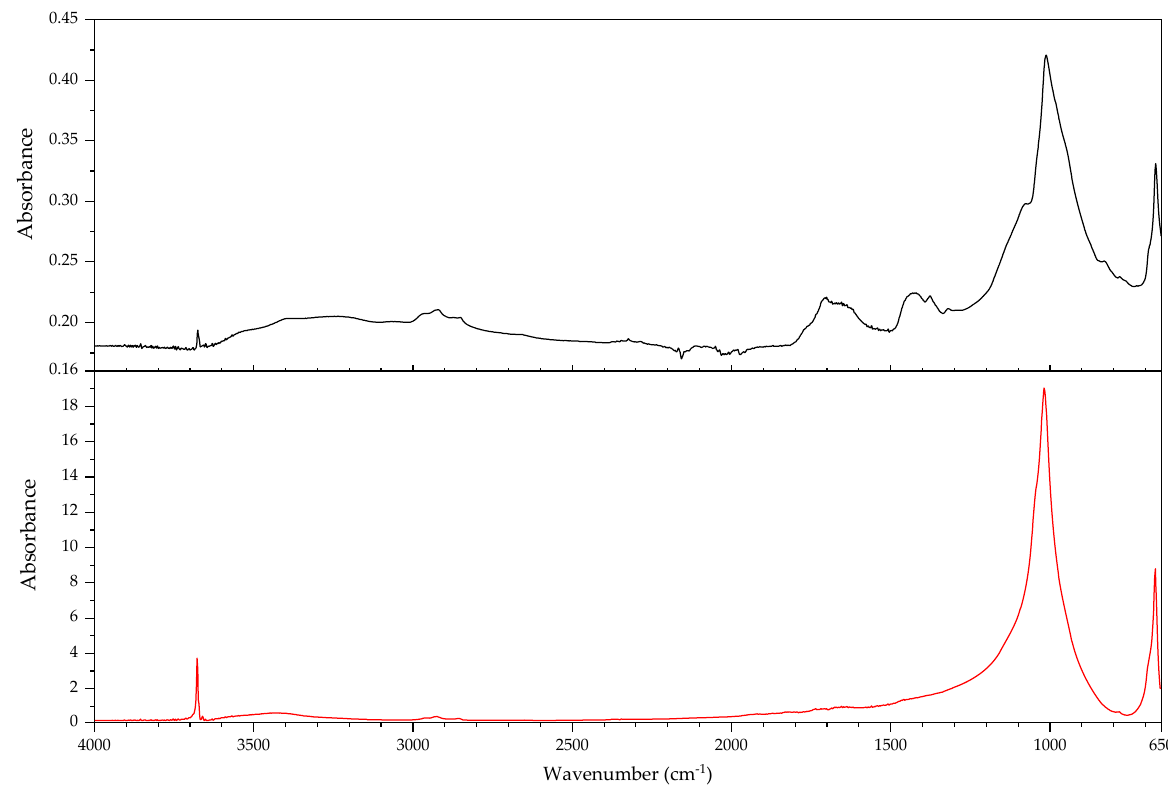
Figure 21. FTIR spectrum of the blooming of object 579 (black line) compared to reference spectrum of talc (red line) from a commercial database.